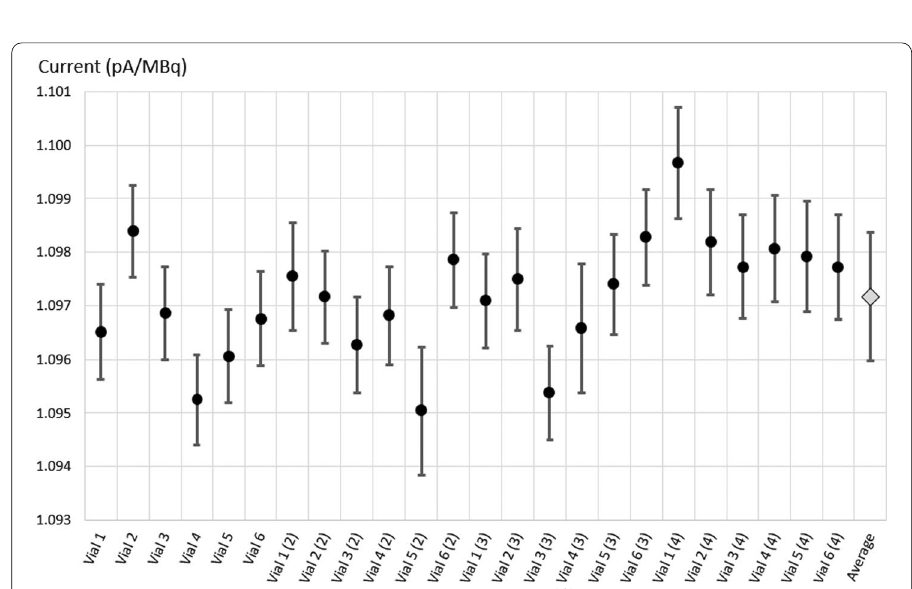
Fig. 9 Normalized current values for 6 sterile glass vials filled with 161 Tb. Each vial was measured 4 times at regular